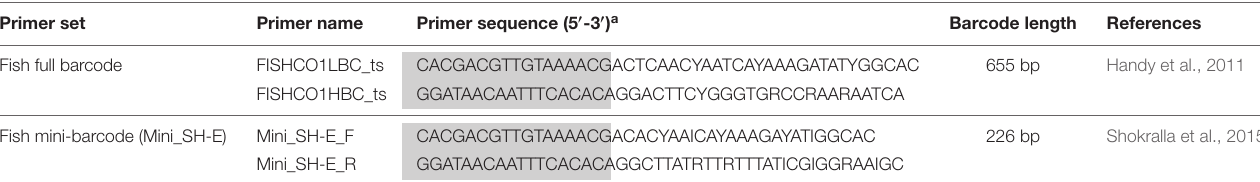
TABLE 2 | Primer sets used in this